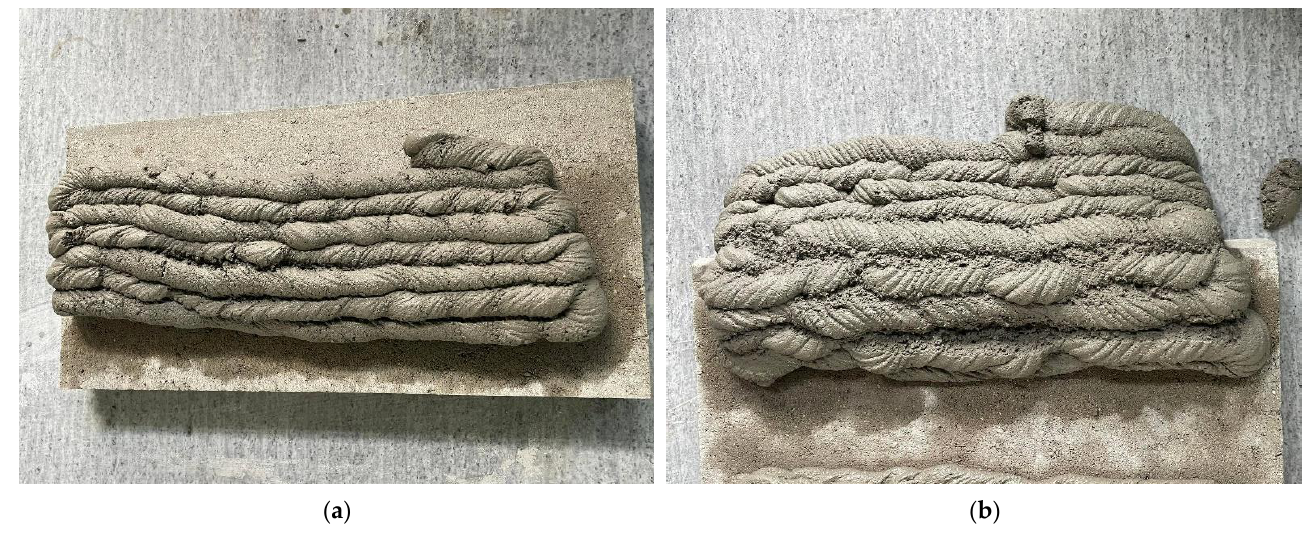
Figure 9. Examples of mixtures that have collapsed before reaching demanded number of layers and thus failed to meet the requirements of the test ( a ) mixture C_A, ( b ) mixture C_B.